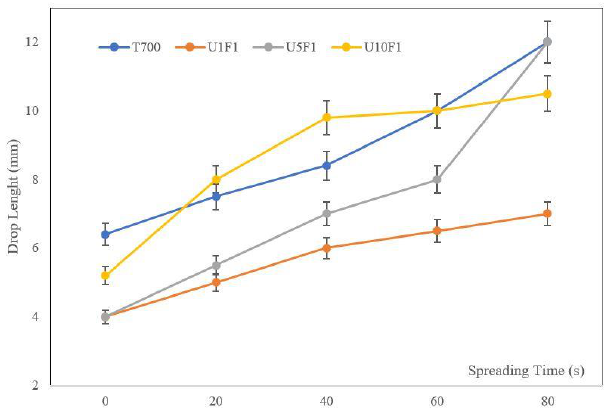
Figure 6. Spreadabillity testing on CNF-based sized CF bundles.